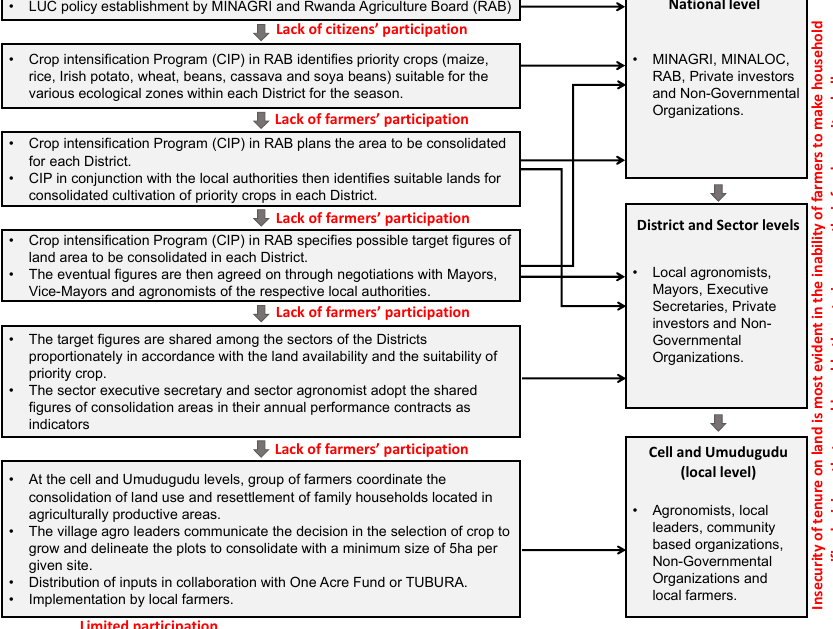
Figure 8. The overall process of the LUC.